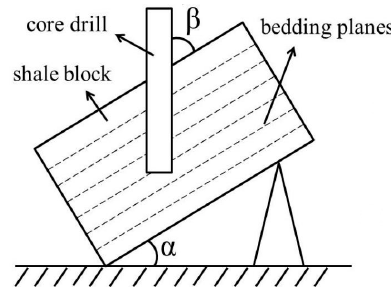
Figure 3. Core-drilling schematic diagram.